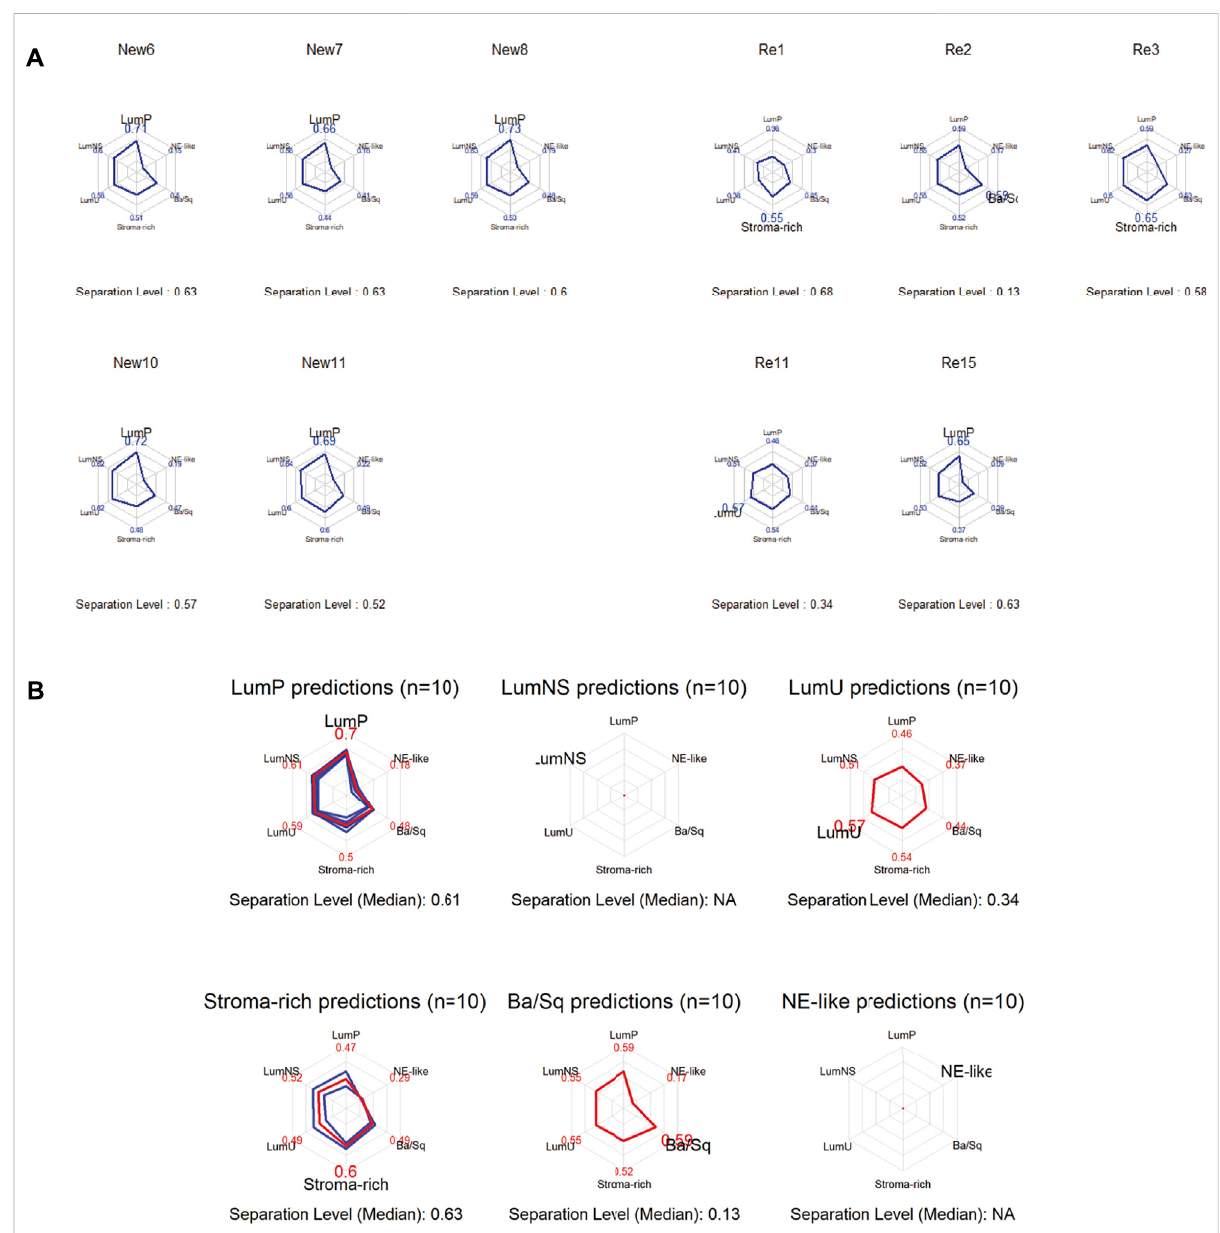
FIGURE 6 miRNA editing events are associated with CMS classi fi cation in bladder tumors. (A) Individual CMS classi fi cation results of 5 recurrent and 5 primary tumors. (B) Overview of CMS prediction of all 10